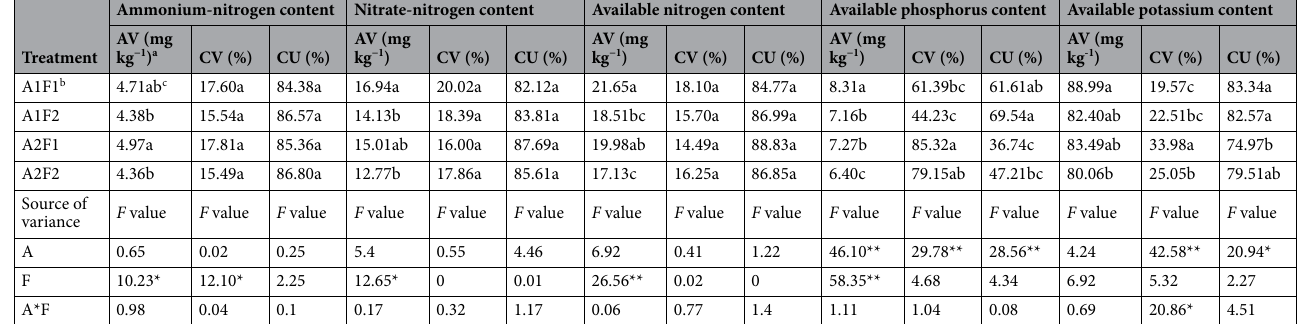
Available nitrogen content Available phosphorus content Available potassium